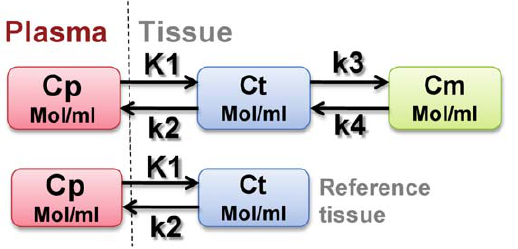
Figure 2. The three-compartment model describing RGD tracer kinetics in tumor and the two-compartment model describing RGD tracer kinetics in reference tissue. Cp represents tracer concentration in arterial blood plasma. Ct represents the free or non- specific binding of tracer in interstitial and intracellular space. Cm represents the portion of RGD tracer bound specifically to integrin. K 1 , k 2 , k 3 and k 4 are the transport and binding rates of the tracer. K1 [ml/g/ min] reflects the perfusion rate into tissue. k 2 [1/min] represents the clearance rate from plasma. k 3 [1/min] is the specific binding rate and k 4 [1/min] is the dissociation